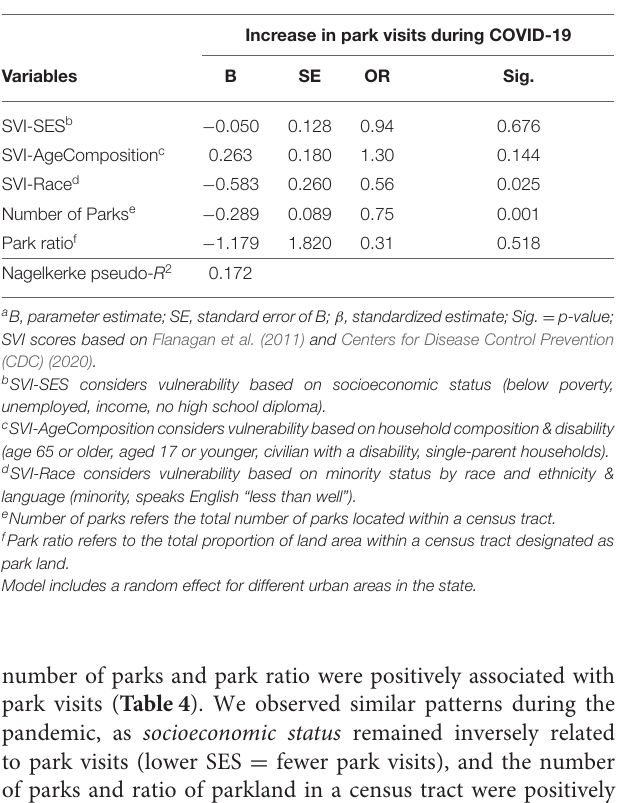
TABLE 5 | Results of mixed effects logistic regression model a investigating associations between various census tract-level measures of social vulnerability (based on the social vulnerability index, SVI) and changes in park visits before and during the COVID-19 pandemic (1 = increase or no change in visits, 0 = decrease in visits) in North Carolina (NC),